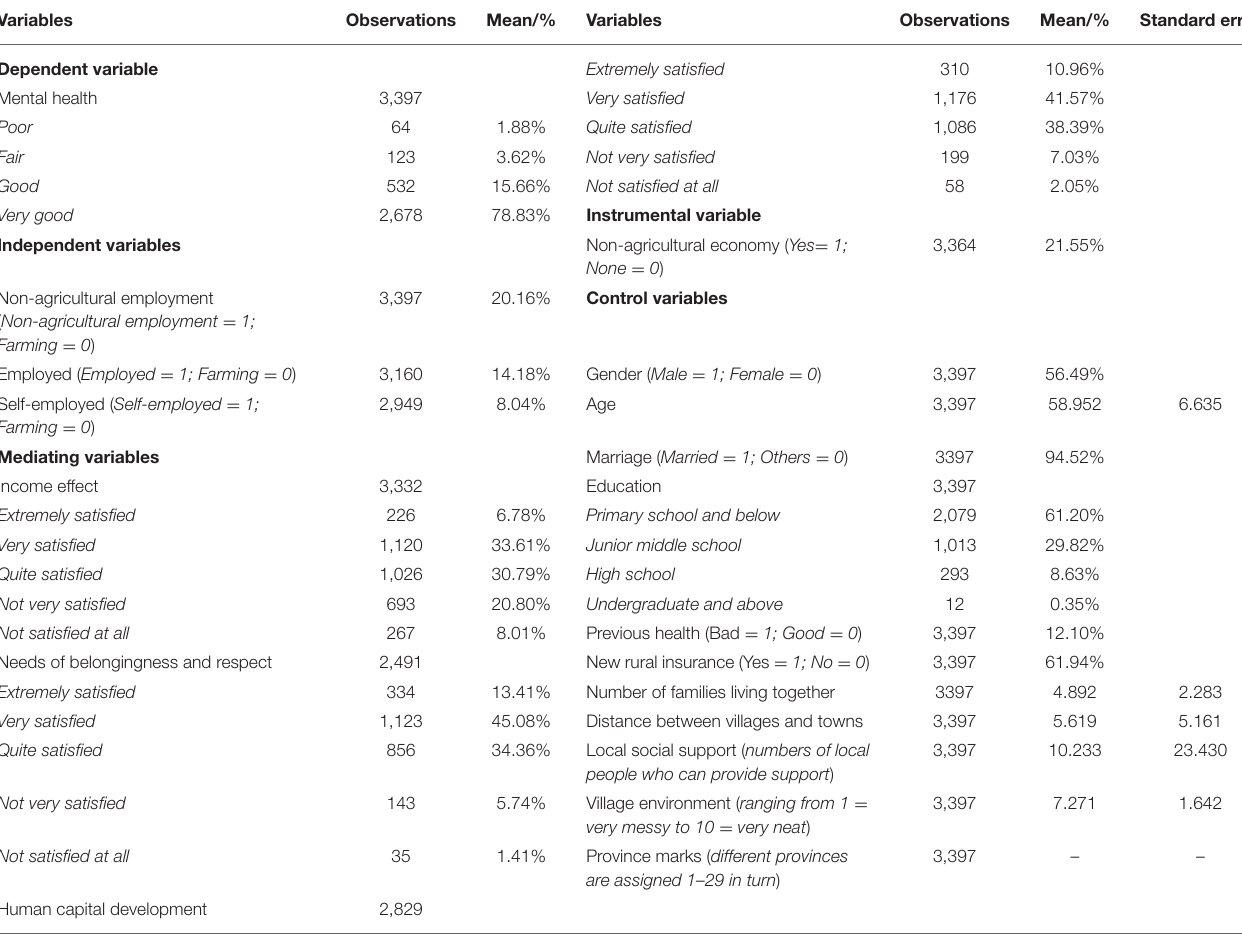
TABLE 1 | Descriptive statistical results of